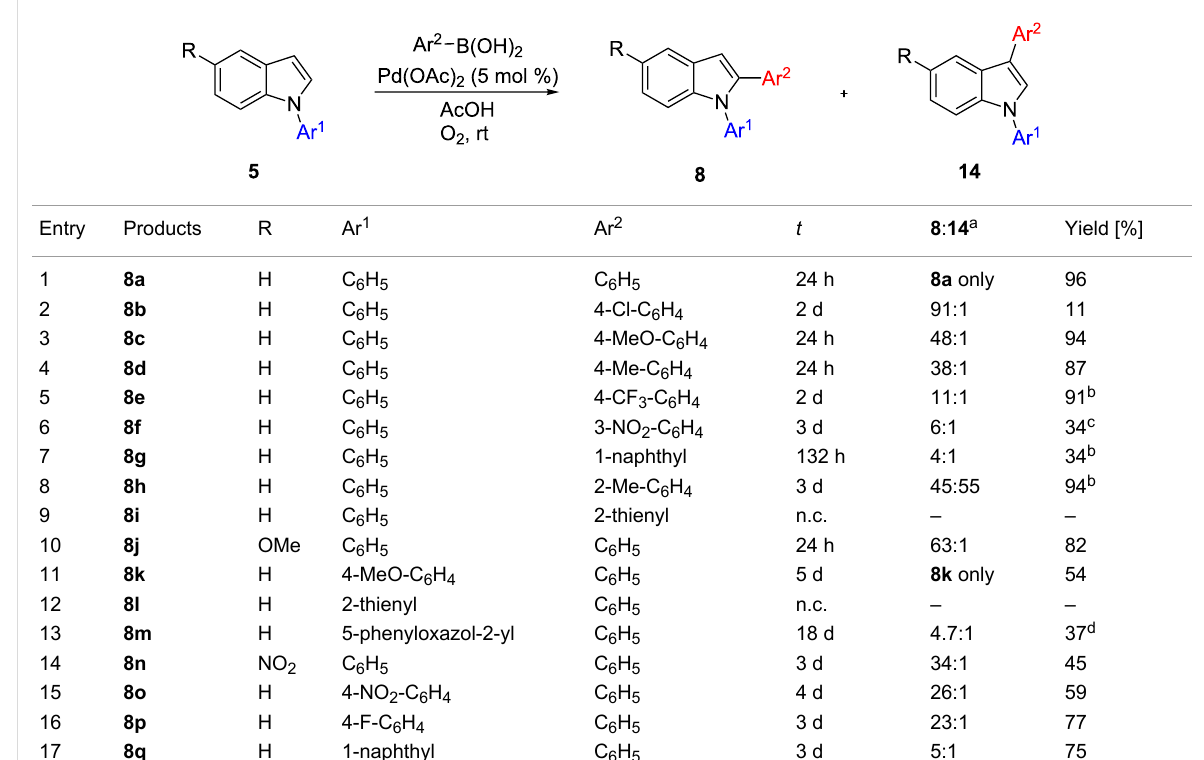
Table 6: Scope of regioselective C2-arylation of 1-arylindoles 5